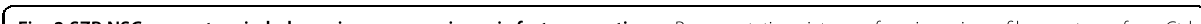
Fig. 2 SZP NSC present an imbalance in neuro-angiogenic factor secretion. a Representative pictures of angiogenic pro fi le secretome from Ctrl NSC and SZP NSC. Red boxes indicate positive internal control spots; blue boxes indicate negative controls. b Quanti fi cation of angiogenic protein levels of ( a ) 3 Ctrl NSC CM versus 3 SZP NSC CM. Data are shown as level of expression relative to internal control and graphed as mean ± SD; * p < 0.05 according to Mann – Whitney test. c Heatmap depicting the levels of angiogenic proteins present in 3 Ctrl NSC CM (#1, #2 and #3), 3 SZP NSC CM (#1, #2 and #3), 3 Ctrl Nsp CM (#1, #2 and #3) and 3 SZP Nsp CM (#1, #2 and #3). Data are shown as average level relative to internal control. d –